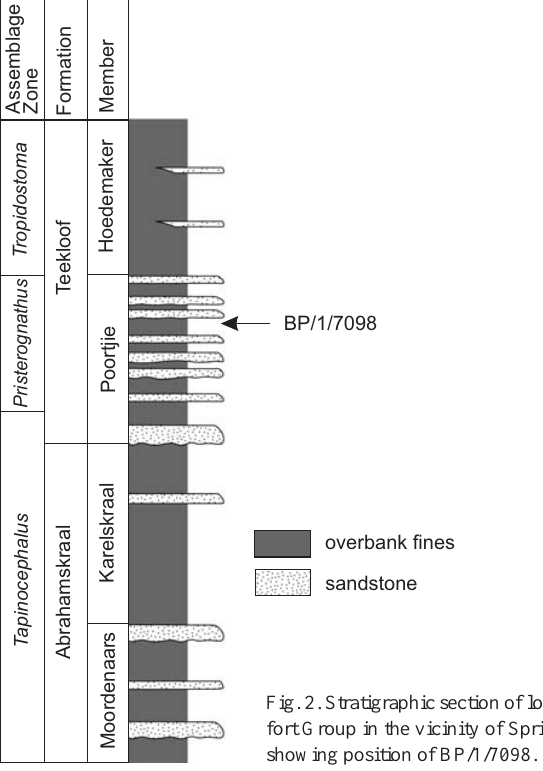
Fig. 2. Stratigraphic section of lower Beau- fort Group in the vicinity of Spring fontein, showing position of